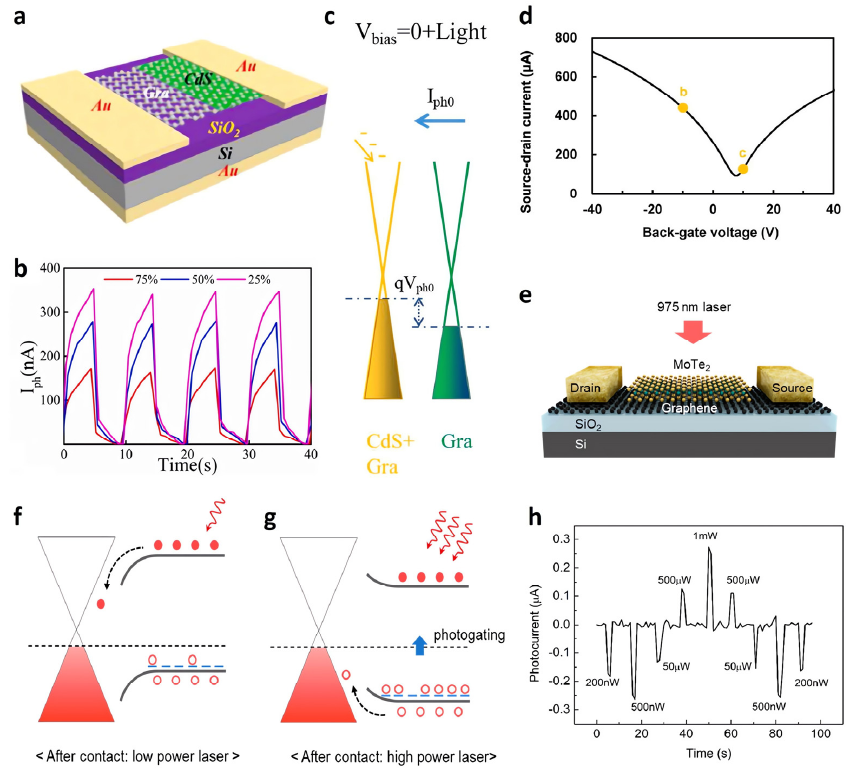
Figure 1. Graphene-based photodetector. ( a ) Graphene–CdS heterostructure schematic. ( b ) The I Ph changes as the area of CdS covering graphene increased from 25% to 75%. ( c ) Schematic band diagram of a graphene–CdS heterostructure under light irradiation in V bias = 0. ( d ) V G –I D curve of a graphene-based photodetector using an InSb substrate under dark conditions. The lowest I D was obtained at a V G of approximately 7.7 V. ( e ) Schematic diagram of a graphene–MoTe 2 heterostruc- ture. Schematic band diagram of a graphene–MoTe 2 heterostructure at ( f ) a low intensity of light and ( g ) a high intensity of light. ( h ) I Ph (I Laser –I Dark ) at various laser powers as a function of time. ( a – c ) Reproduced with permission from [80]. Copyright Elsevier, 2022. ( d ) Reproduced with permis- sion from [83]. Copyright AIP Publishing, 2018. ( e – h ) Reproduced with permission from [84]. Cop- yright American Chemical Society, 2020. 2.2. TMD- and BP-Based Photodetectors Two-dimensional transition metal dichalcogenides (2D TMDs) have the advantages of a tunable bandgap, a layer number-dependent band structure, easy fabrication, ultrast- ability, a high on-current (I On )/off-current (I Off ) ratio, high electron mobility ( μ ), and high R [4,85–87]. On the other hand, their slow response requires charge-trapping layers, such as adsorbates and oxides [5,88–90]. Integrating an oxide layer in TMDs is not easy, but surface oxidation of atomically thin TMDs was one of the breakthroughs. In 2018, Yama- moto et al. treated a tungsten diselenide (WSe 2 ) surface with O 3 to form a self-limiting oxide layer, which is WO x [91]. It served as a photogating medium, providing electron trap sites and extending the carrier lifetime. As a result, the I Ph showed persistent photo- conductivity (PPC) behavior (Figure 2a). A high R of 3663 A·W − 1 was obtained using white light with an intensity of 1.1 nW. Group-10 TMDs have excellent optical and electronic properties, which respond to light in a broadband wavelength range from visible to mid- infrared, and are appropriate for ultrathin and flexible photodetectors [92,93]. In 2021, Yang et al. produced Se vacancies as hole trap sites by tape exfoliation to overcome the low R (0.4–6.25 A·W − 1 ) of PtSe 2 [94]. The photogenerated holes trapped in the Se defects